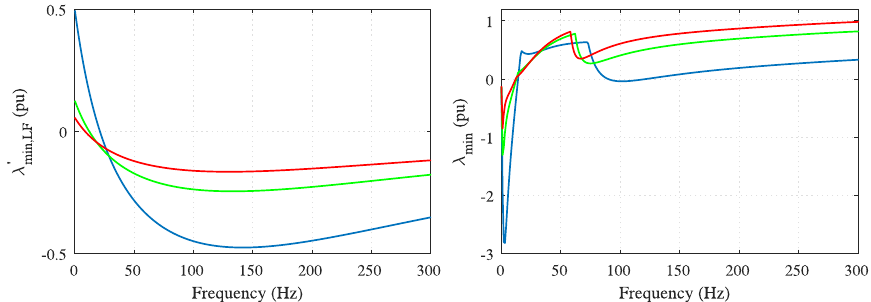
Figure 13. Frequency characteristic of λ (cid:48) R v = 0.02 pu (blue), R v = 0.06 pu (green), and R v = 0.10 pu (red).